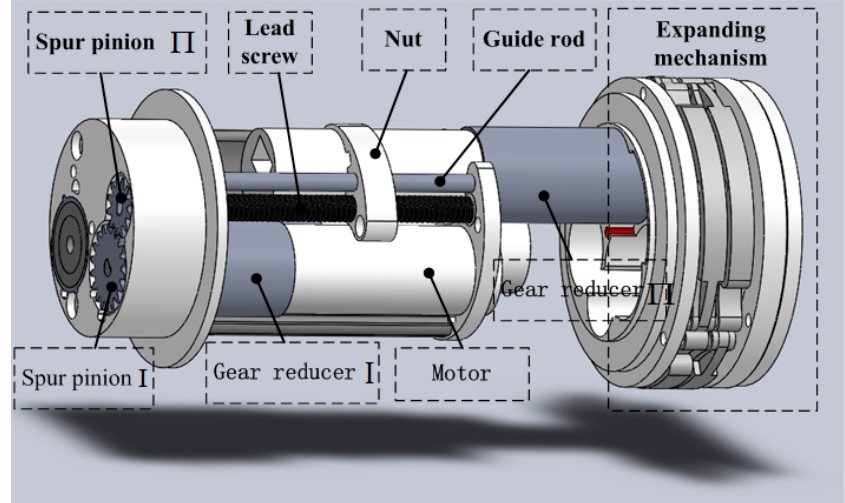
Figure 3. Structure of the designed telescoping mechanism. Table 2. The designed parameters of the novel inchworm-like intestinal micro-robot (IIMR).